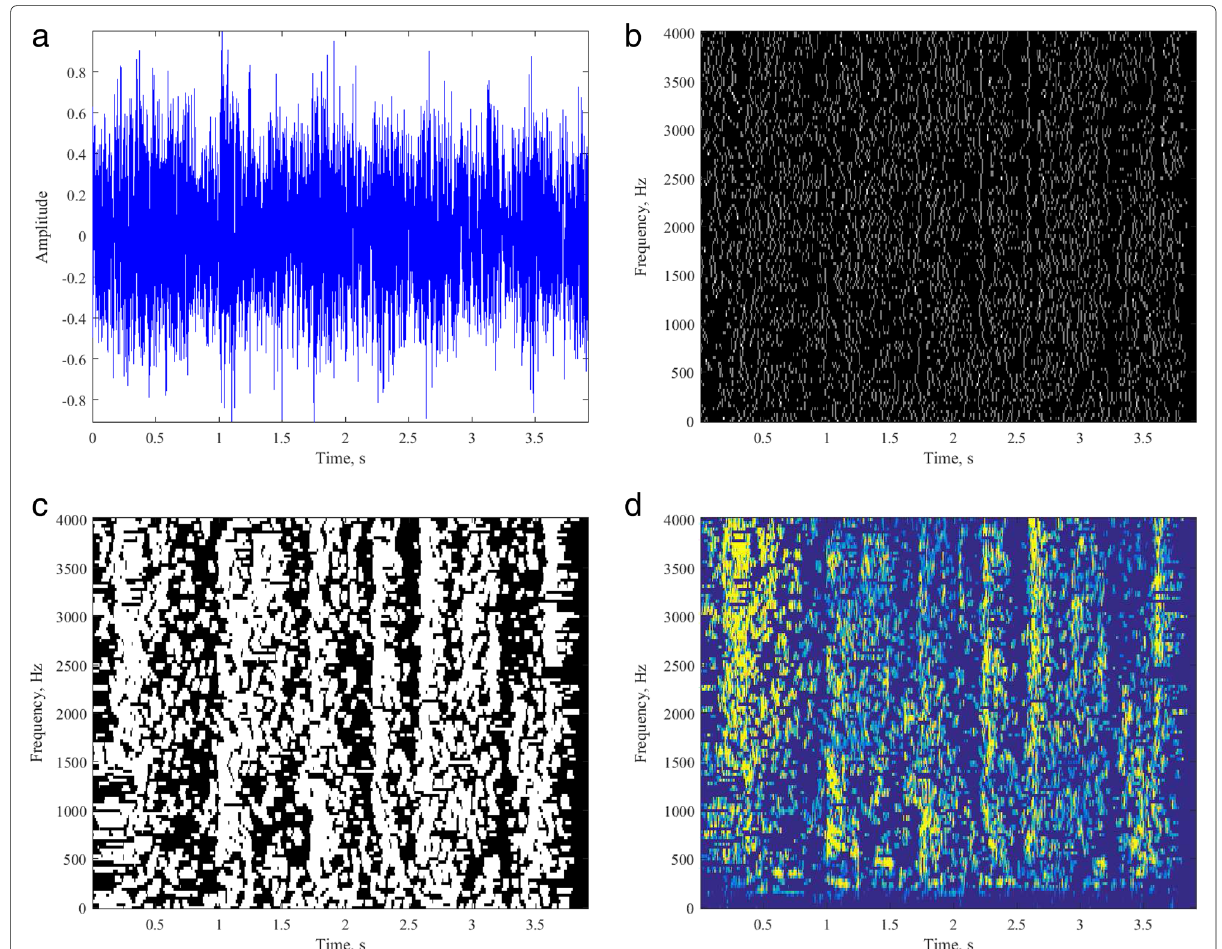
Fig. 6 Representation of the speech signal smeared by factory noise ( − 5 dB) ( a ), its starting and ending point candidates using rules (i) and (ii) ( b ), masks ( c ), and speech period candidates as a result of multiplying masks by the spectra expressed in decimal form ( d